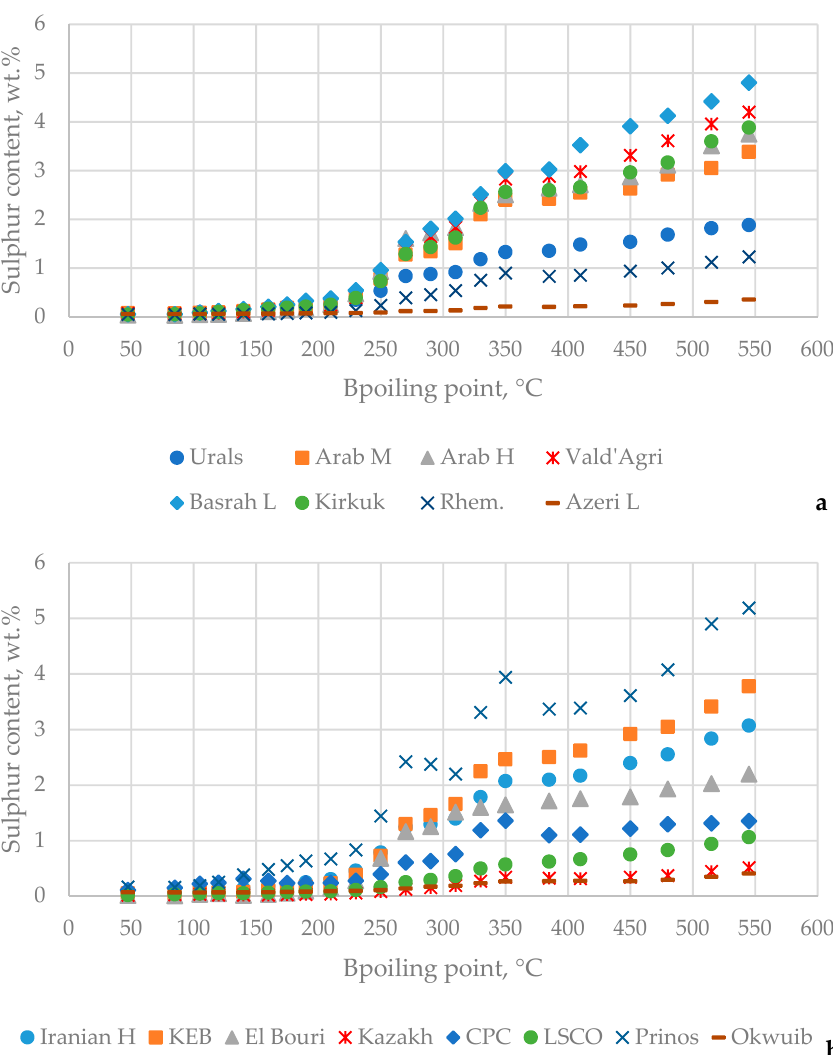
Figure 7. Distribution of sulphur in the boiling point range of some of the studied crude oils ( a , b ).